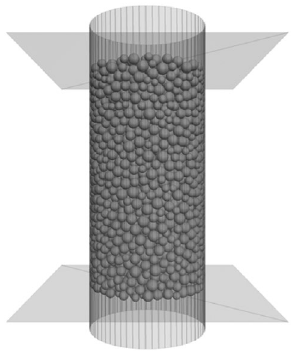
Figure 8. Particle model constructed with PFC3D.